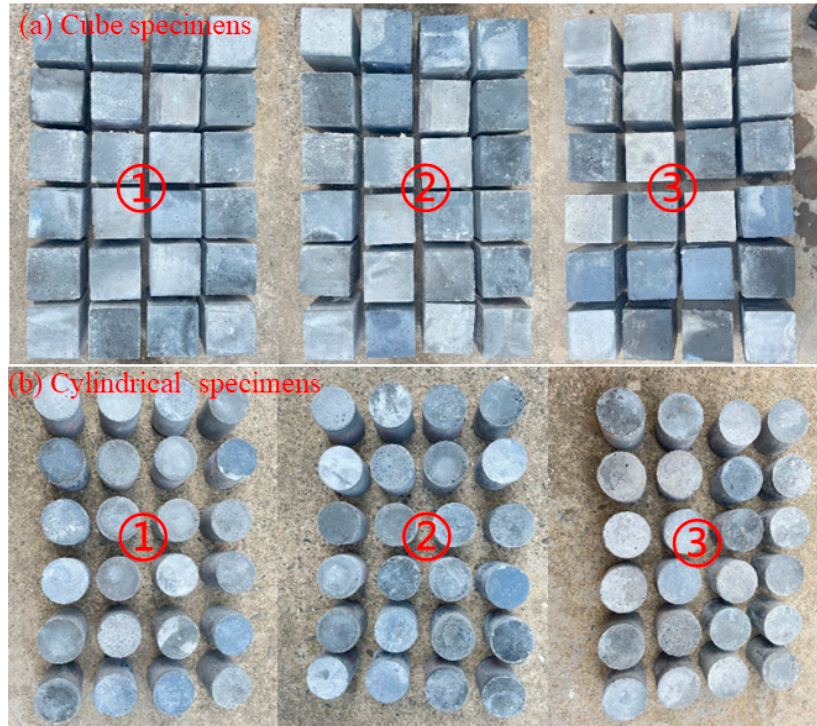
Figure 1. The cubic and cylindrical HPC specimens. ( a ) cube specimens, ① group 1, ② group 2, ③ group 3,( b ) Cylindrical specimens, ① group 1, ② group 2, ③ group 3.